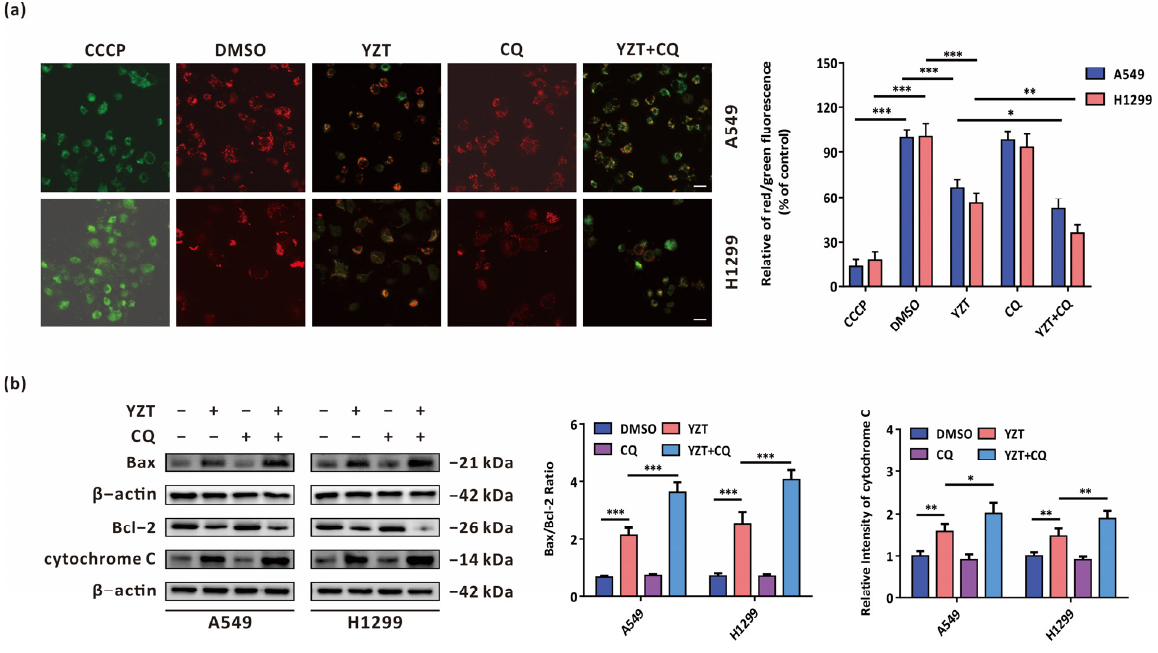
Figure 5. Autophagy inhibition aggravates YZT-mediated mitochondrial apoptosis. ( a ) JC-1 staining assay indicated that YZT plus CQ further lowers MMP compared with YZT alone. CCCP was used as the positive control. Scale bar: 10 μ m. ( b ) Immunoblotting showed that combined treatment of YZT with CQ further upregulated the ratio of Bax/Bcl-2 and the level of cytochrome C compared to YZT alone. Significant differences were designated as * p < 0.05, ** p < 0.01 and *** p < 0.001.